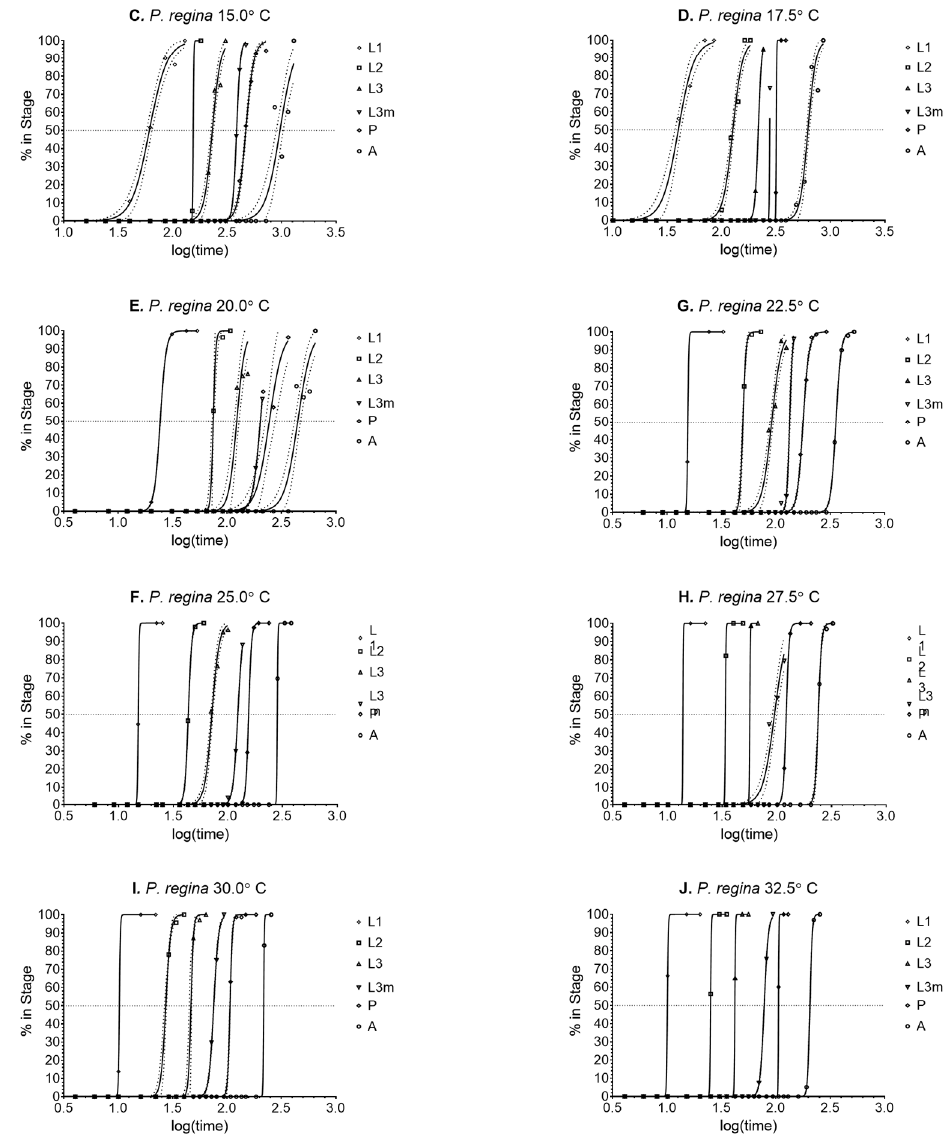
Figure 4. ( A – E ). Probit analysis curves used to determine 50% of the transition population for Phormia regina at 10.0–32.5 °C ( A – J , respectively). Confidence intervals are represented by dotted lines.